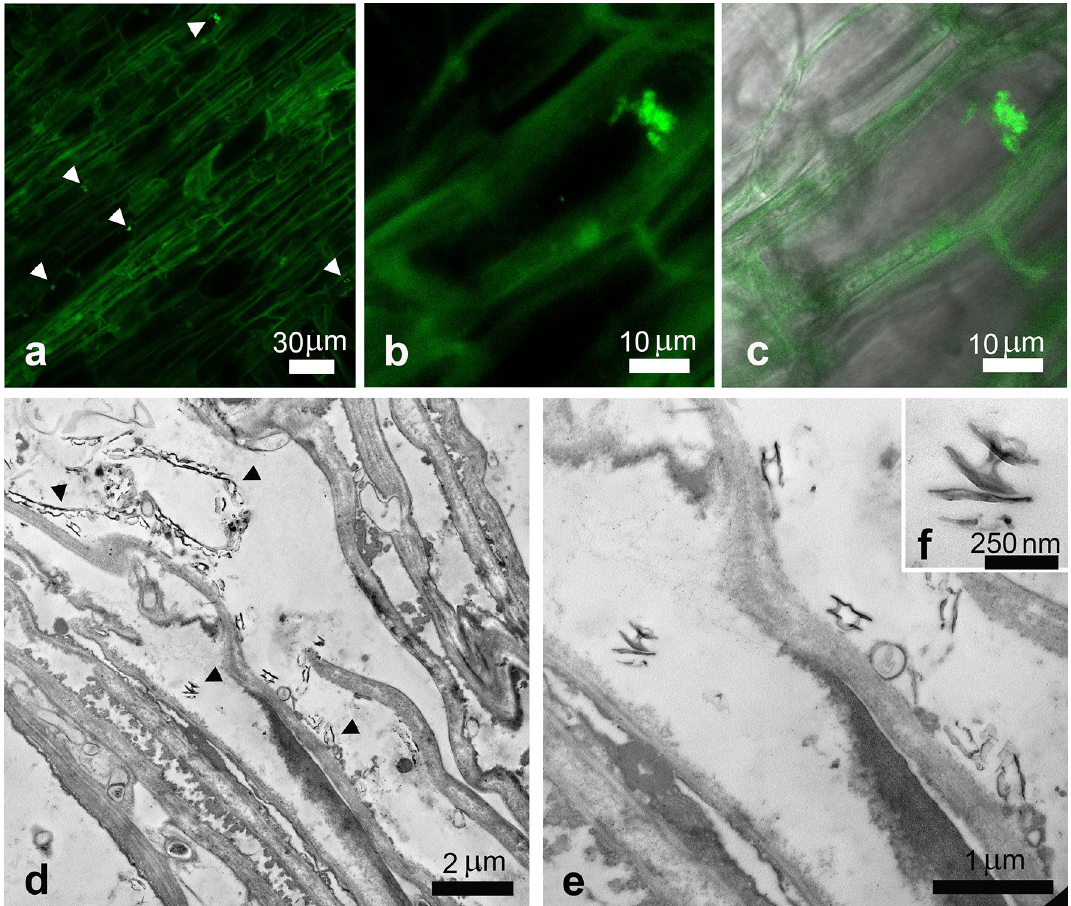
Figure 5. Confocal images of olive root treated with 1% w/v CNCs in longitudinal sections, where some fluorescent spots were revealed in the first layers of root parenchymatic cells (( a–c ), arrowheads). Ultrastructural analysis by TEM evidenced the presence of needle-like structures in the cellular symplast, compatible with CNCs (( d–f ), arrowheads).